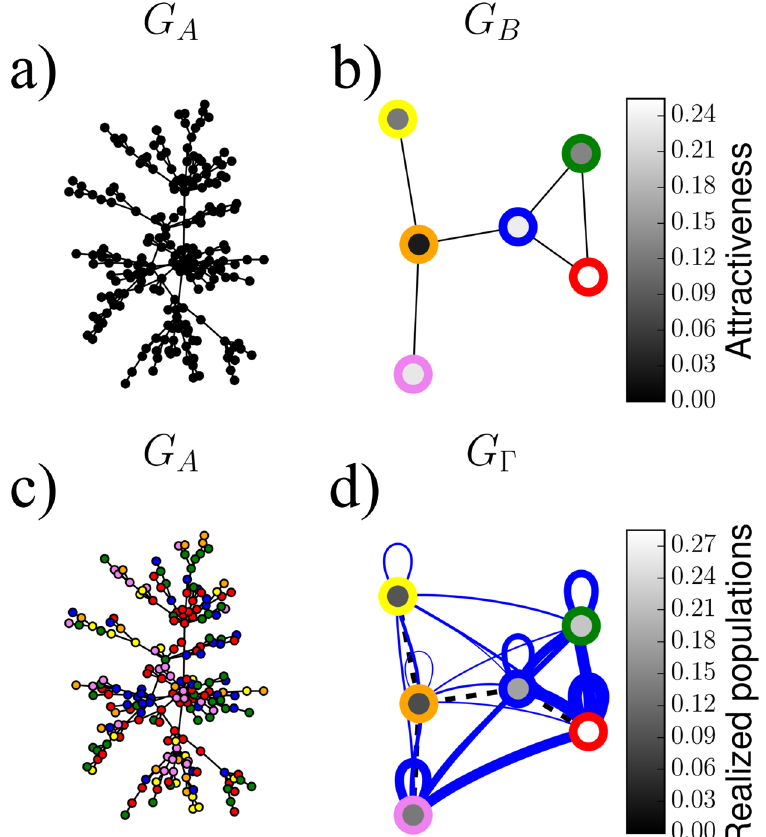
Figure 1. Example of the network embedding model. ( a ) Visualization of network A, here a BA network 23 of size N A = 100 and parameter m = 1. ( b) Network B is very simple for illustrative purposes. The outside coloring of each node represents its label and the inside color represents its attractiveness. ( c) The nodes in A have been assigned to location nodes in B and the color of each network A node matches the outside coloring of a network B node. ( d) Embedded network Γ G . The outside coloring of each node is the same as in G B whereas the inside color represents the percentage of network A nodes that have been assigned to the given node in network